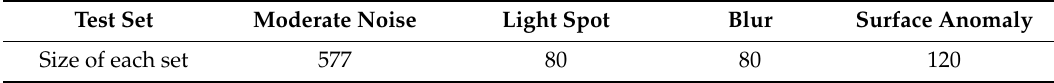
Table 4. Four test sets types and the number of pictures contained.